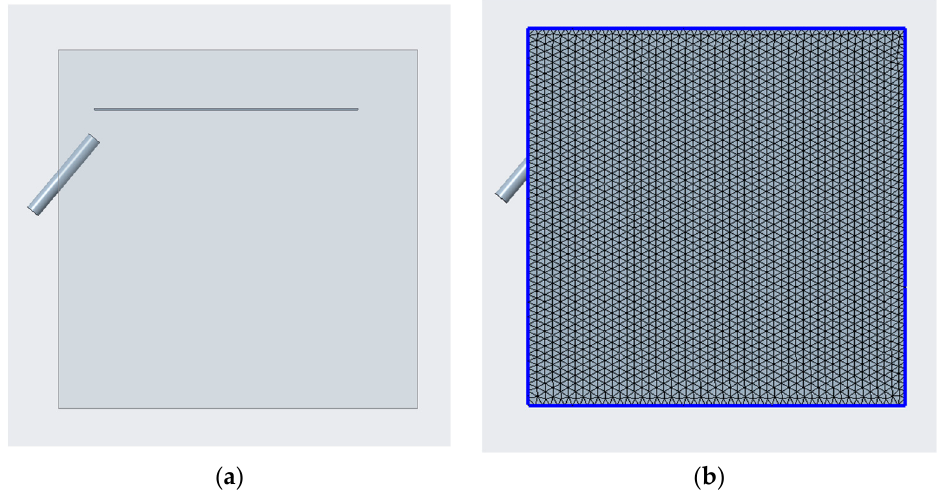
Figure 2. Inner and outer domain meshing: ( a ) simulation of the internal and external domains; ( b ) mesh division.